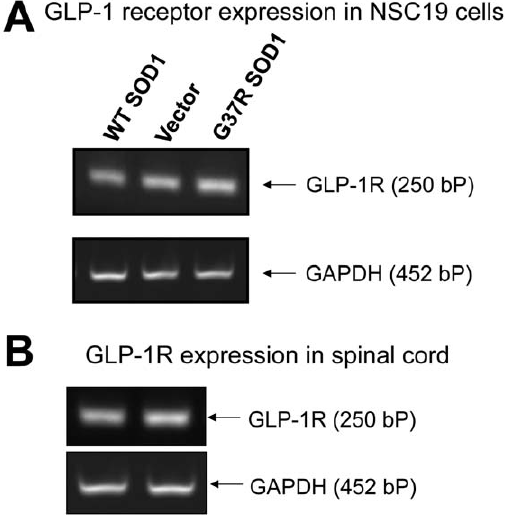
Figure 1. GLP-1R is expressed in NSC19 cells and mouse spinal cord. ( A ) A representative RT-PCR analysis showing expression of GLP- 1R in stable transfected NSC19 cell lines (from left to right: NSC19 cells expressing wildtype SOD1, NSC19 cells expressing empty vector, NSC19 cells expressing G37R mutated SOD1). ( B ) A representative RT-PCR analysis showing expression of GLP-1R in wildtype C57Bl/6 mouse spinal cord (2 lanes represent 2 different mice). Glyceraldehyde 3- phosphate dehydrogenase (GAPDH) was utilized as an internal control. Using specific primers, amplified mouse GLP-1R fragment is 250 bp and GAPDH is 452